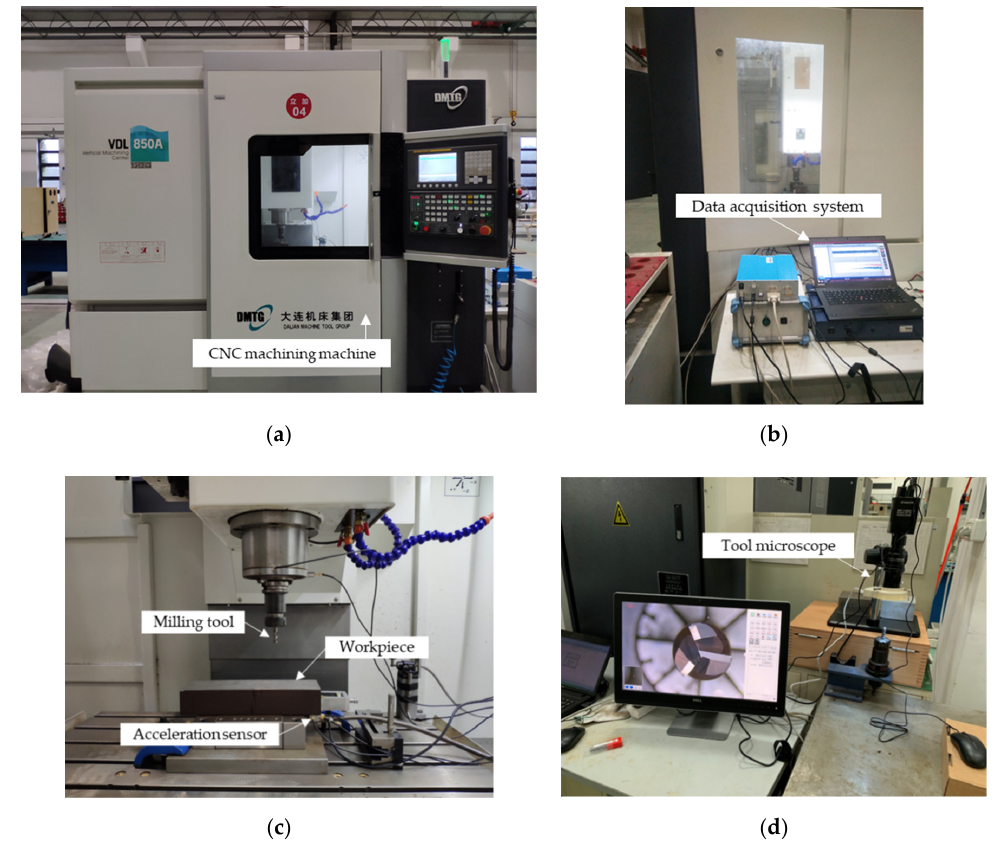
Figure 4. The experimental setting. ( a ) CNC machine, ( b ) data acquisition system, ( c ) experimental platform, and ( d ) tool microscope. platform, and ( d ) tool microscope. Table 2. Experimental